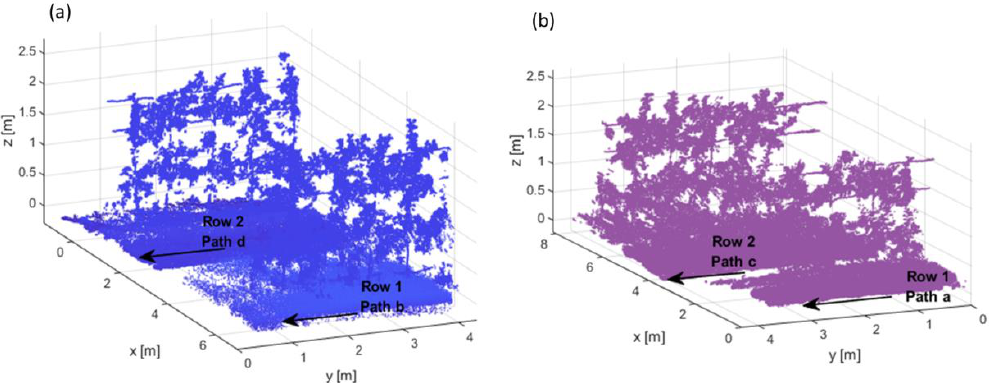
Figure 3. Representation of the point clouds were reconstructed when the LiDAR system on the tractor drove ( a ) through the path a, c on the left side and ( b ) through the path d, b on the right side of apple trees. For illustration purposes, only a part of each row was presented.